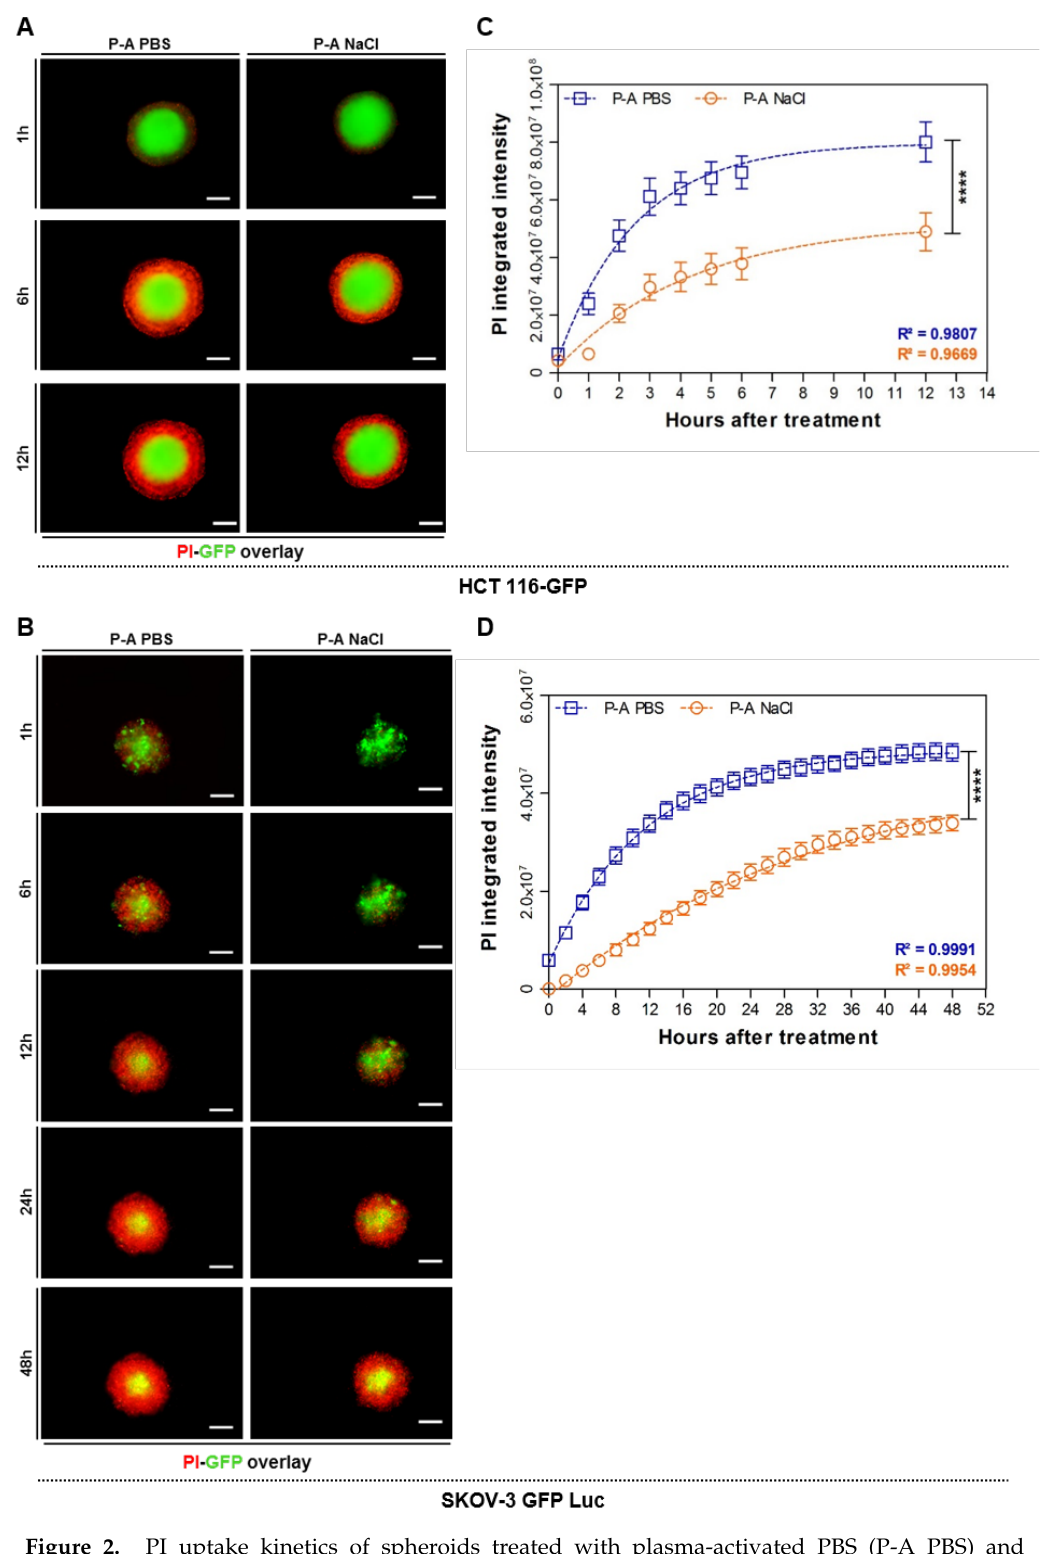
Figure 2. PI uptake kinetics of spheroids treated with plasma-activated PBS (P-A PBS) and plasma-activated NaCl (P-A NaCl). ( A , B ) Overlaid GFP and PI fluorescence micrographs of HCT-116 GFP and SKOV-3 GFP Luc spheroids, 1, 6, 12, 24, and 48 h after treatment with P-A PBS and P-A NaCl. The scale bar is set at 200 µ m. ( C , D ) PI fluorescence integrated intensity across the spheroids as a function of time. Two-way ANOVA, **** p < 0.0001. Fit one-phase association equation: Y = Y 0 + (plateau-Y 0 ) × (1 − e − k t ). N = 3 and 2 independent experiments for HCT-116 GFP and SKOV-3 GFP Luc, respectively, with n = 8 spheroids per experiment.